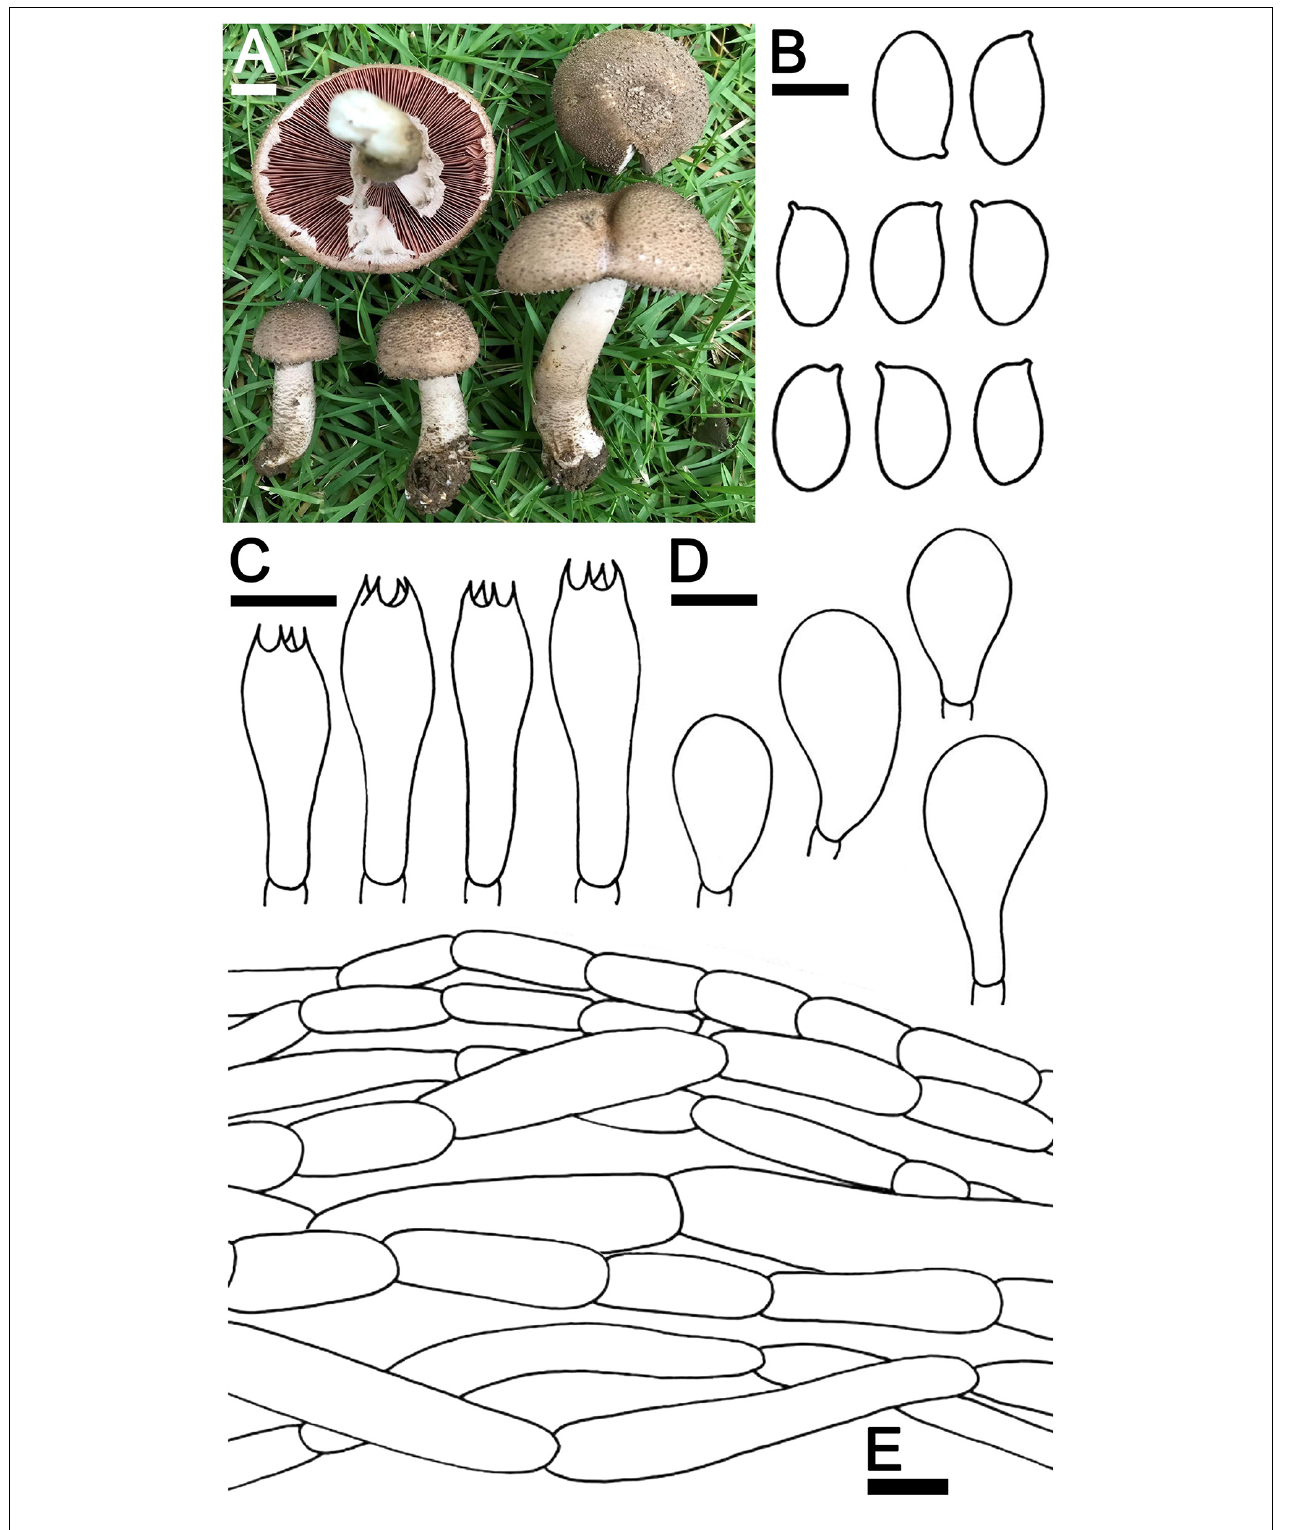
FIGURE 6 | Agaricus pallidobrunneus SDBR-NK0368. (A) Basidiomata on the field, (B) Basidiospores, (C) Basidia, (D) Cheilocystidia, (E) Pileipellis. Scale bars (A) = 1 cm, (B) = 5 µ m, and (C–E) = 10 µ m.